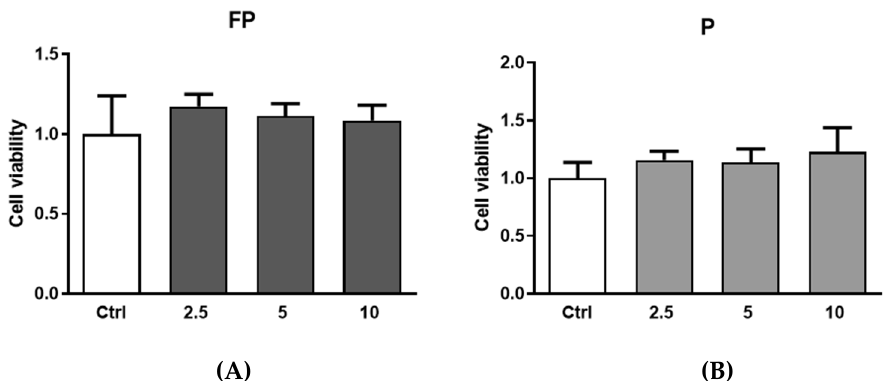
Figure 6. RAW 264.7 were plated in 6-well plates (3.0 × 10 5 cells/well) and treated for 24 h with different concentration of ( A ) FP and ( B ) P solutions (2.5, 5 and 10 µg/mL). Cell viability was deter- mined with the Burker chamber utilizing Trypan Blue as a cell dye. Results are expressed as mean ± SD of at least three experiments. ctrl (control, untreated cells); FP (cells treated with fermented Pushgay); P (cells treated with Pushgay).